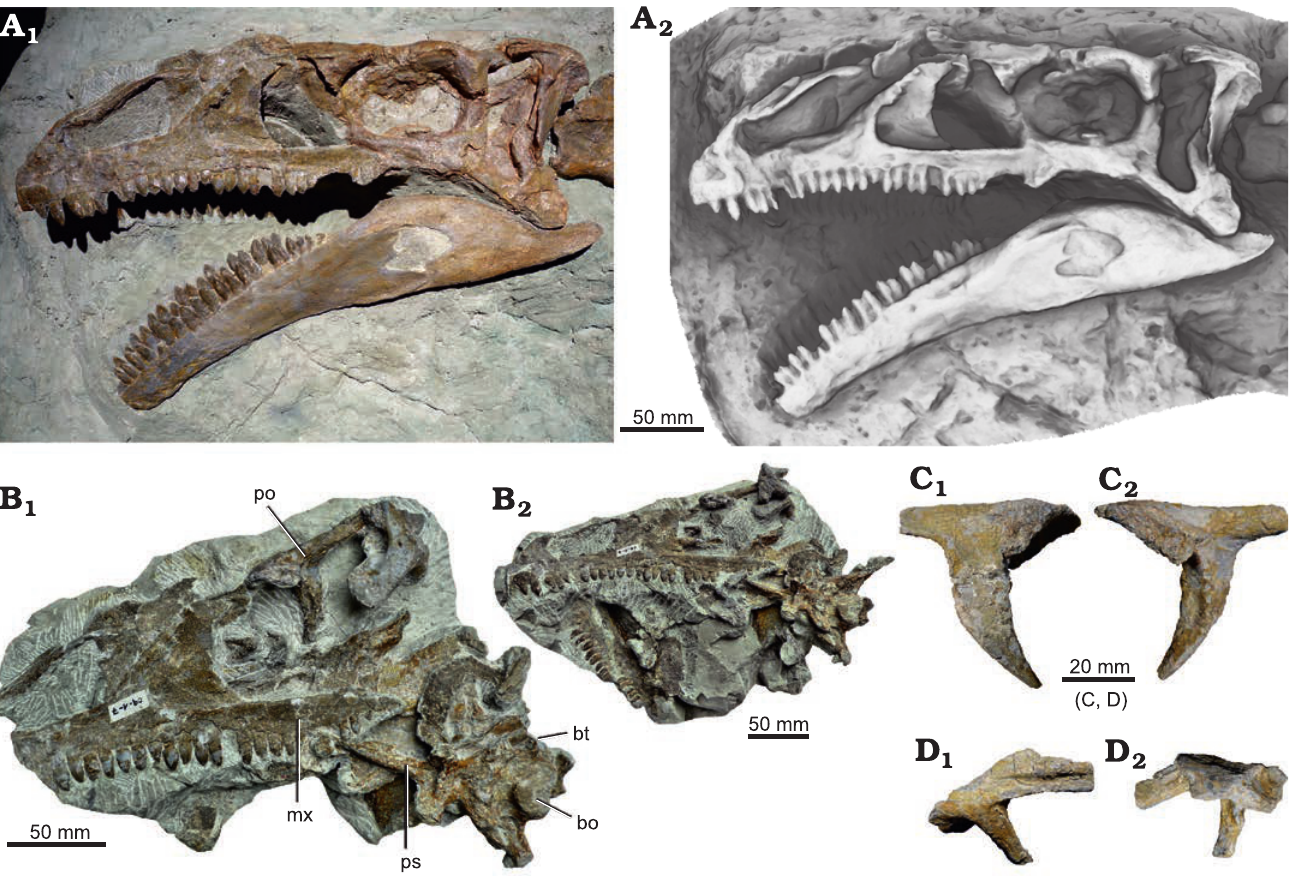
Fig. 10. A . Skull of Plateosaurus trossingensis (SMA 09.1) from the Triassic of Frick, Switzerland. The skull on exhibit at the Sauriermuseum Aathal (SMA) (A 1 ); note that parts posterior to the nasal, maxilla, and dentary are casted from NAAG_00011238; ambient occlusion of the museum exhibit (A 2 ). B . Photograph of the skull during preparation, showing additional elements in place (B 1 ); photograph of the skull at an early stage of preparation (B 2 ). C . Right postorbital in lateral (C 1 ) and medial (C 2 ) views. D . Right squamosal in lateral (D 1 ) and medial (D 2 ) views. Abbreviations: bo, basioccipital; bt, basipterygoid tubera; mx, maxilla; po, postorbital; ps,